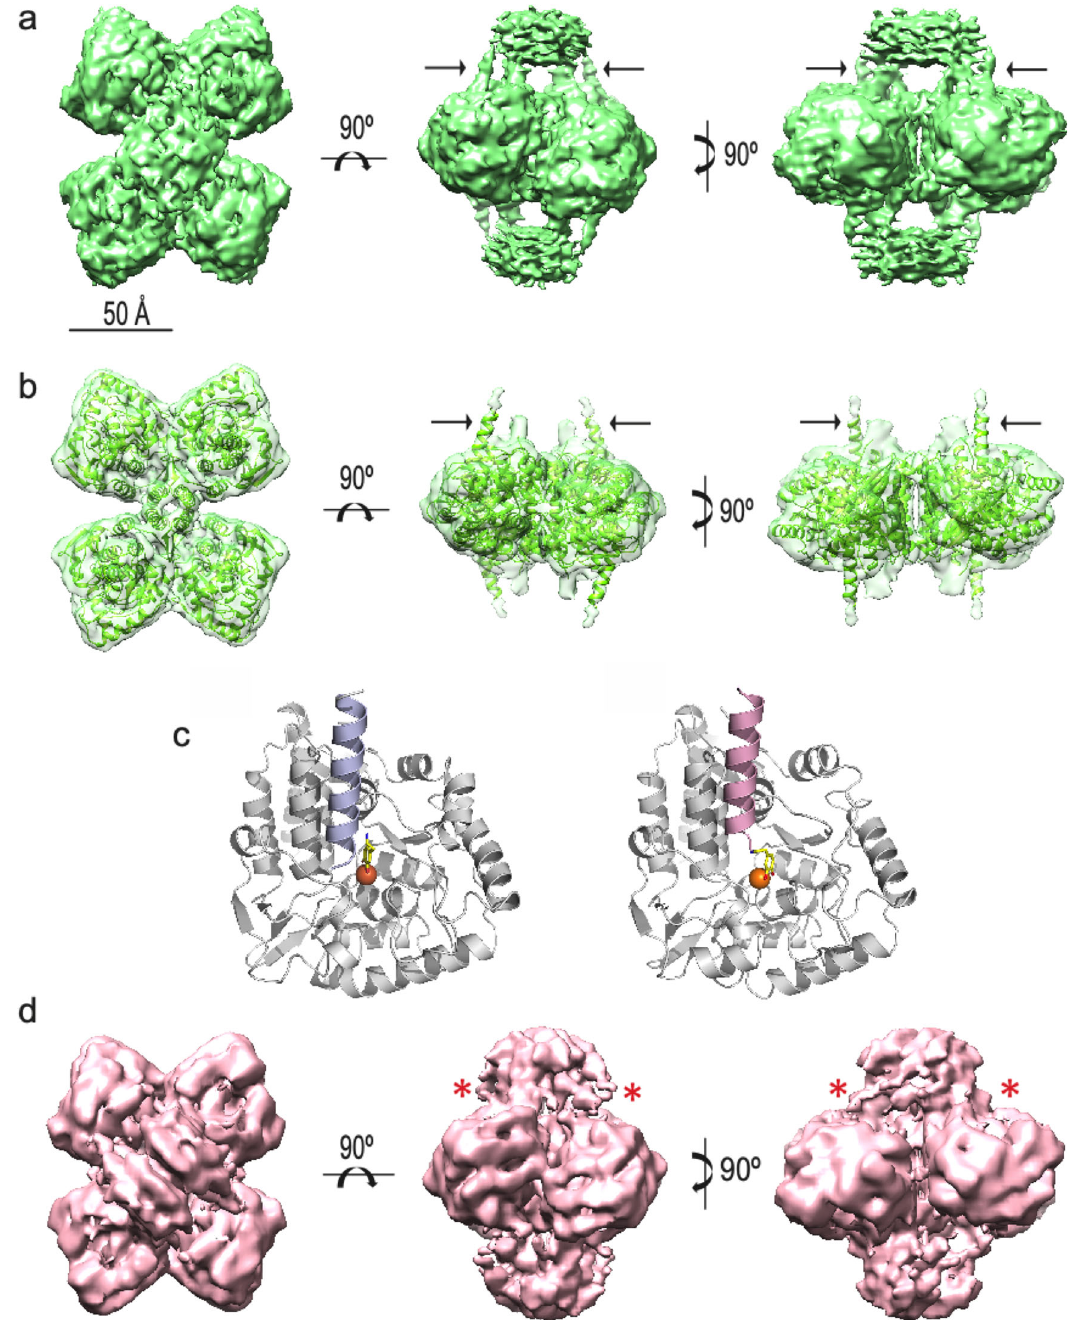
Fig. 4 Three-dimensional reconstructions of different TH variants. a Three orthogonal views of the three-dimensional reconstruction of THN Δ 35 in the presence of DA (THN Δ 35(DA)). The black arrows point to a new mass visualized in TH(DA), which is not present in apo-TH. b The same views with the atomic model of CD + OD domains of THN Δ 35 (the RDs have been removed) docked into the corresponding mass of the THN Δ 35 three-dimensional reconstruction. The black arrows point to the α -helix entering into the active site. c Comparison of the atomic model of the TH active site of TH(DA) (left) and THN Δ 35(DA) (right) showing the similar location of the α -helix inside the active site. d Three orthogonal views of the three-dimensional reconstruction of phosphorylated on S40 (THS40p). The asterisks point to the position where the N-terminal α -helix is located in both TH(DA) and THN Δ 35(DA) reconstructions, but absent in this